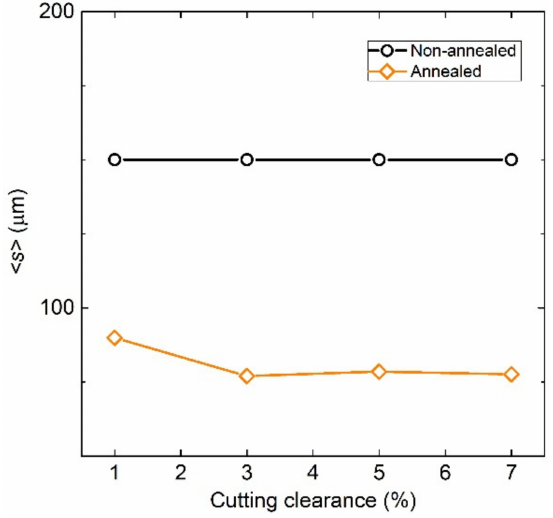
Figure 4. Comparison of mean grain size in non-annealed and annealed